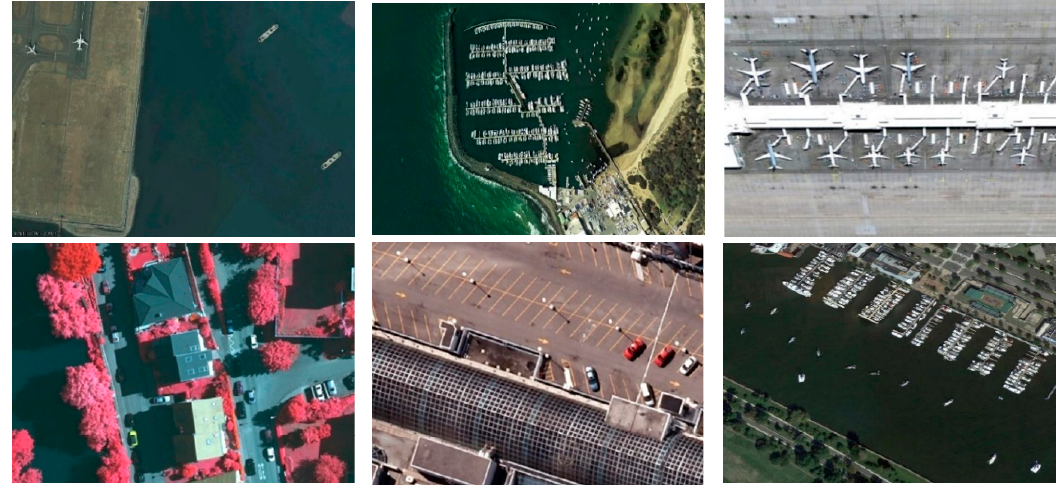
Figure 1. Objects often have very different appearances and scales, and sometimes appear with a very complicated surrounding area in remote sensing images.